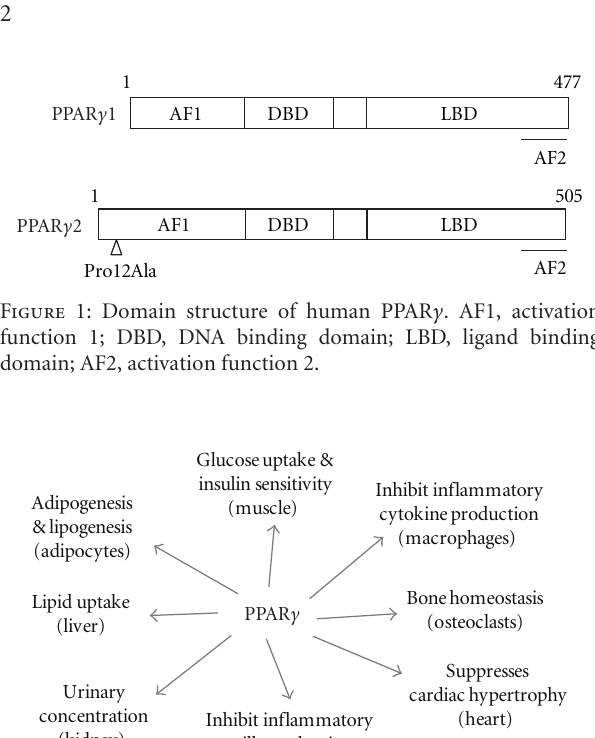
(PPAR γ 2 Pro12Ala ) is the most common. This mutation was first identified by Schuldiner’s group in 1997 [37], with dif- ferent ethnic populations showing various allelic